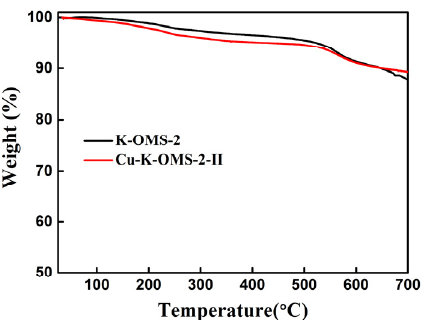
Figure 4. Thermogravimetric analysis (TGA) profiles, weight loss versus temperature, for K-OMS-2 and Cu-K-OMS-2-II.